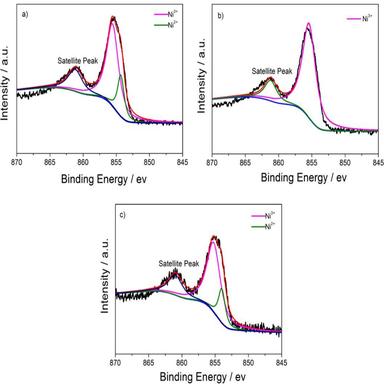
XPS spectra and corresponding fitting curves of Ni 2p (a): 750 C, 15 h, and 1:1.1. (b) 800 C, 15 h, and 1:1.1. (c) 850 C, 15 h, and 1:1.1.